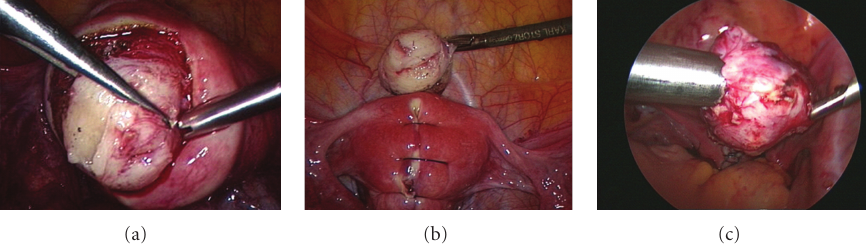
Figure 1: Myomectomy: (a) intraoperative sight of the myoma and its surrounding vascularized capsula. (b) Reconstruction of the uterine wall after excision of the tumor. (c) Removing the myoma by morcellation.